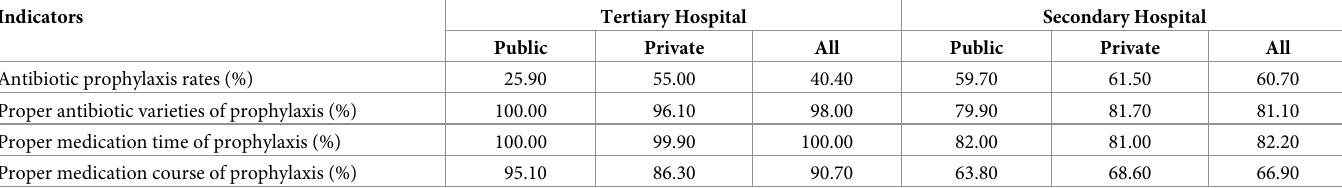
Table 6. Antibiotic use in Class I incision surgery.